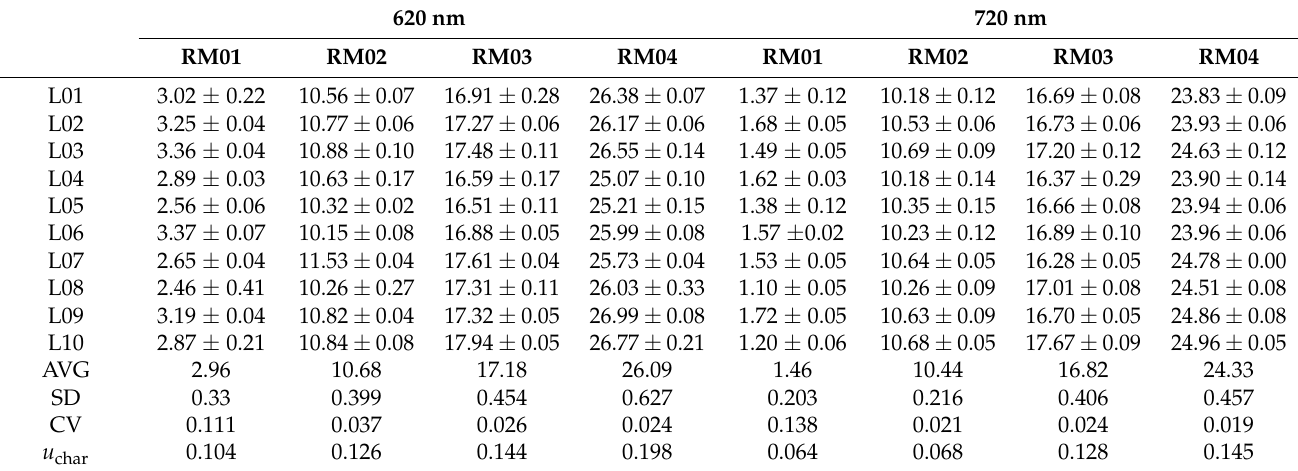
Table 4. Analysis of AAC of the four rice reference materials from ten laboratories a